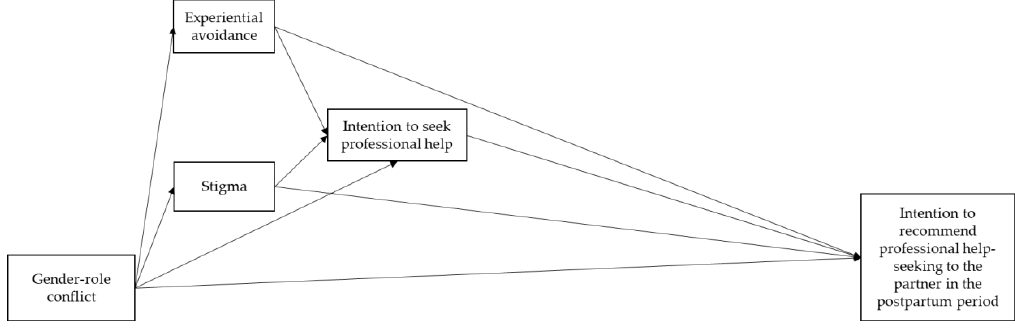
Figure 1. Conceptual scheme of the direct and indirect effects of gender-role conflict on the intention to recommend professional help-seeking to a partner with PMAD, through experiential avoidance, stigma, and the intention to seek professional help.